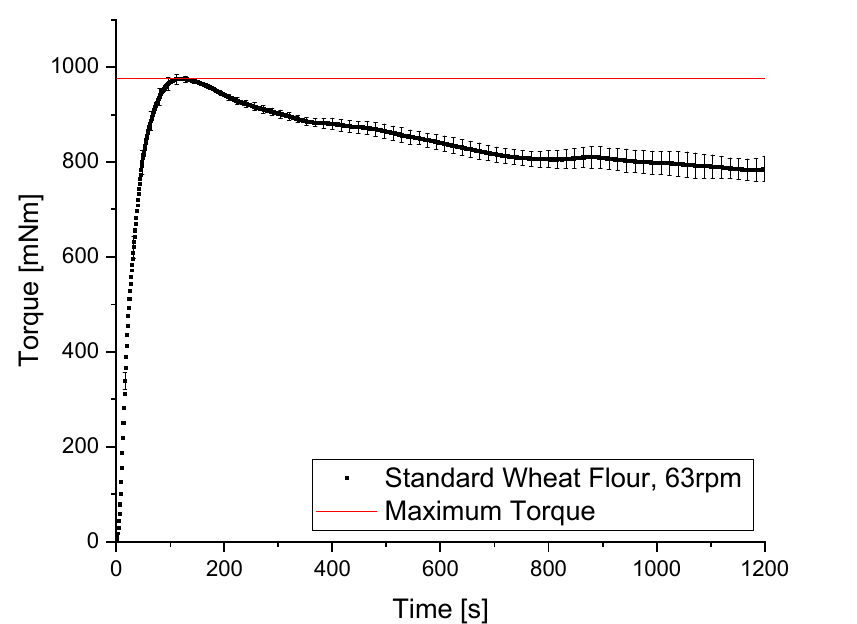
Figure 2. Kneading curve for standard wheat flour measured in a torque recording Z-Kneader (DoughLAB). Maximum peak resistance is marked at 976 mNm. Means are shown with standard deviation (n = 3). Table 1. Selected kneading times to evaluate the network evolution along the ongoing kneading process of standard wheat flour water